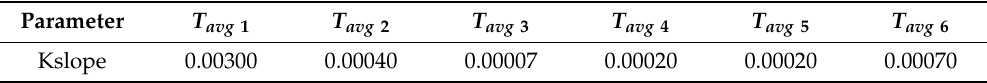
Table 6. Comparison of distribution torque speed constants at no load.